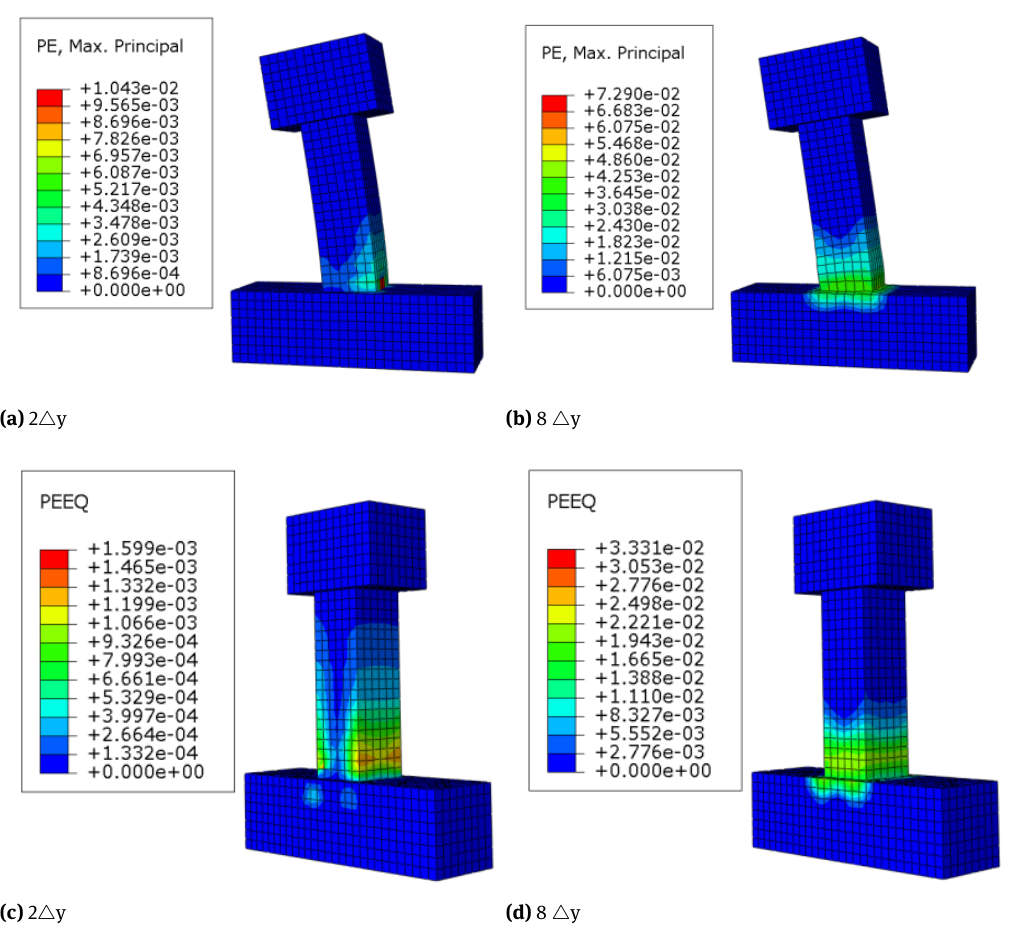
Figure 8: Nephograms of Equivalent Plastic Strain and Maximum Principal Plastic Strain of C2